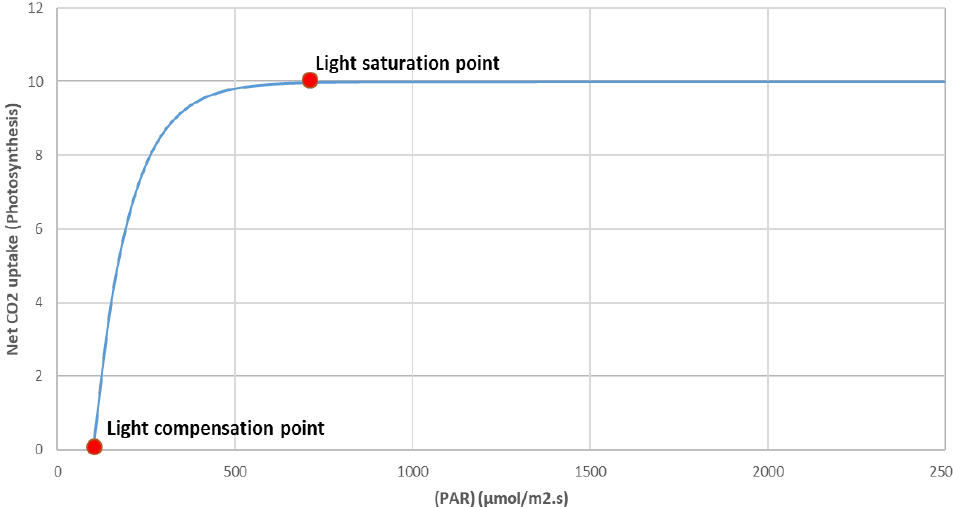
Figure 12. Photosynthesis light curve response showing the LCP and LSP points.